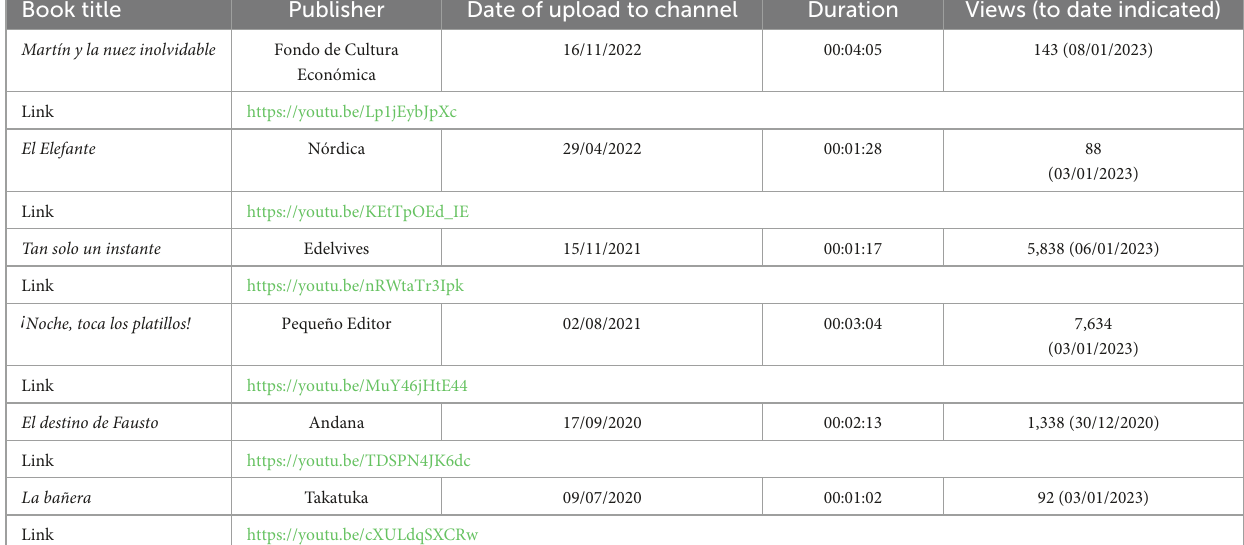
TABLE 8 Examples of virtual epitexts focusing on understanding and the creative process.